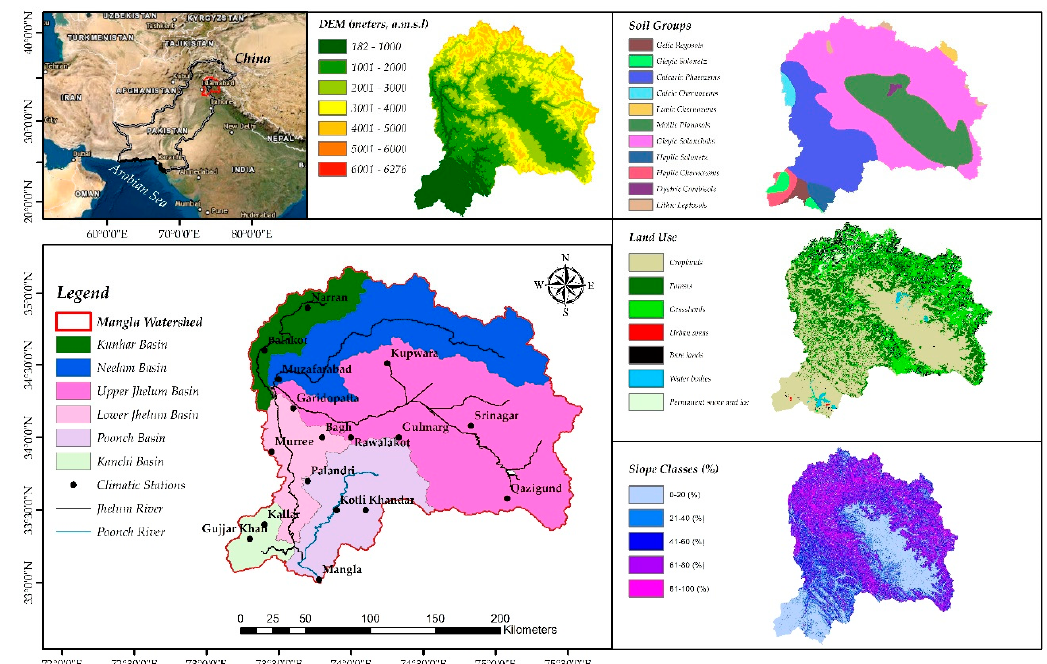
Figure 1. Study area map along with metrological stations, digital elevation model (DEM), sub-basins, land use, Slope classes, and soil groups.